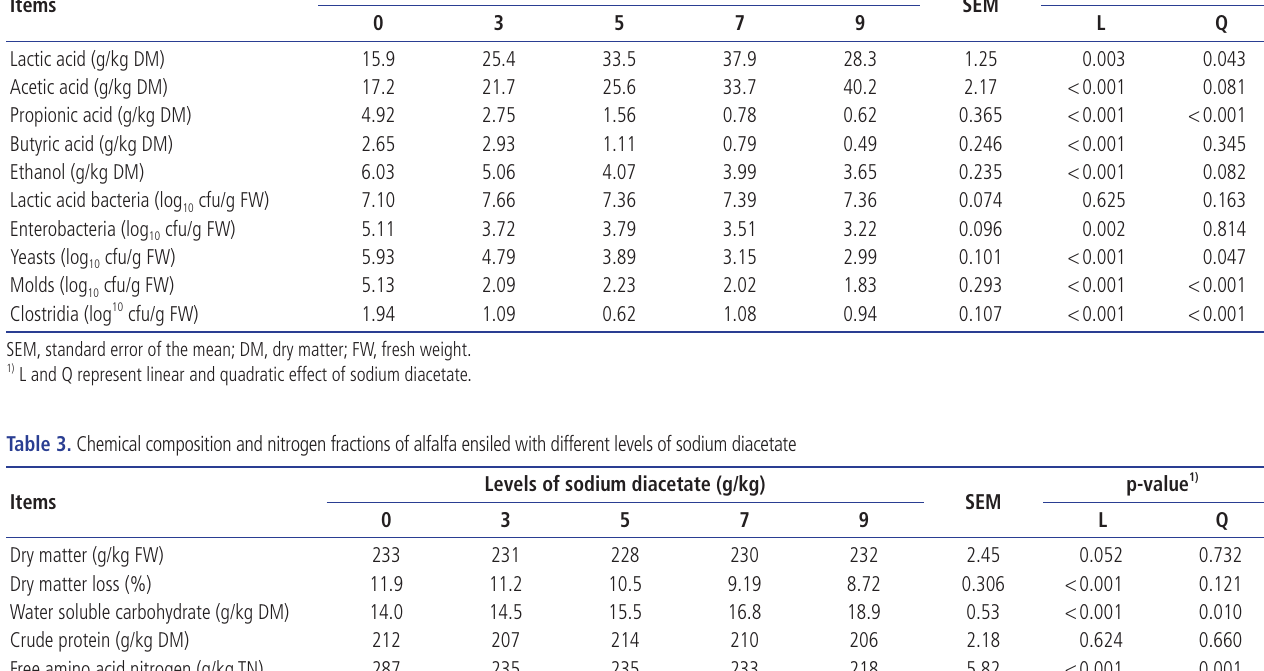
Table 2. Fermentation characteristics and microbial populations of alfalfa ensiled with different levels of sodium diacetate Items